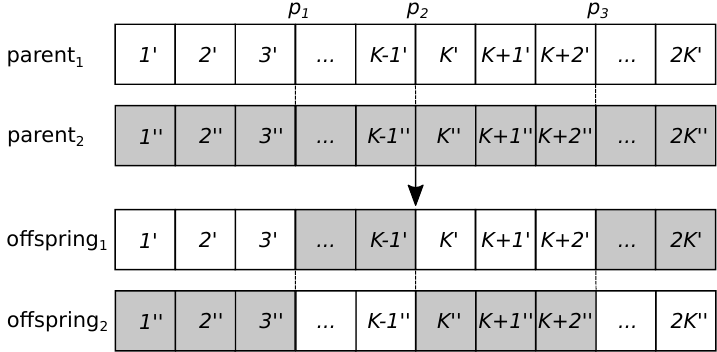
Figure 3. Example of the three point recombination operator for the Non-dominated Sorting Genetic Algorithm, version II